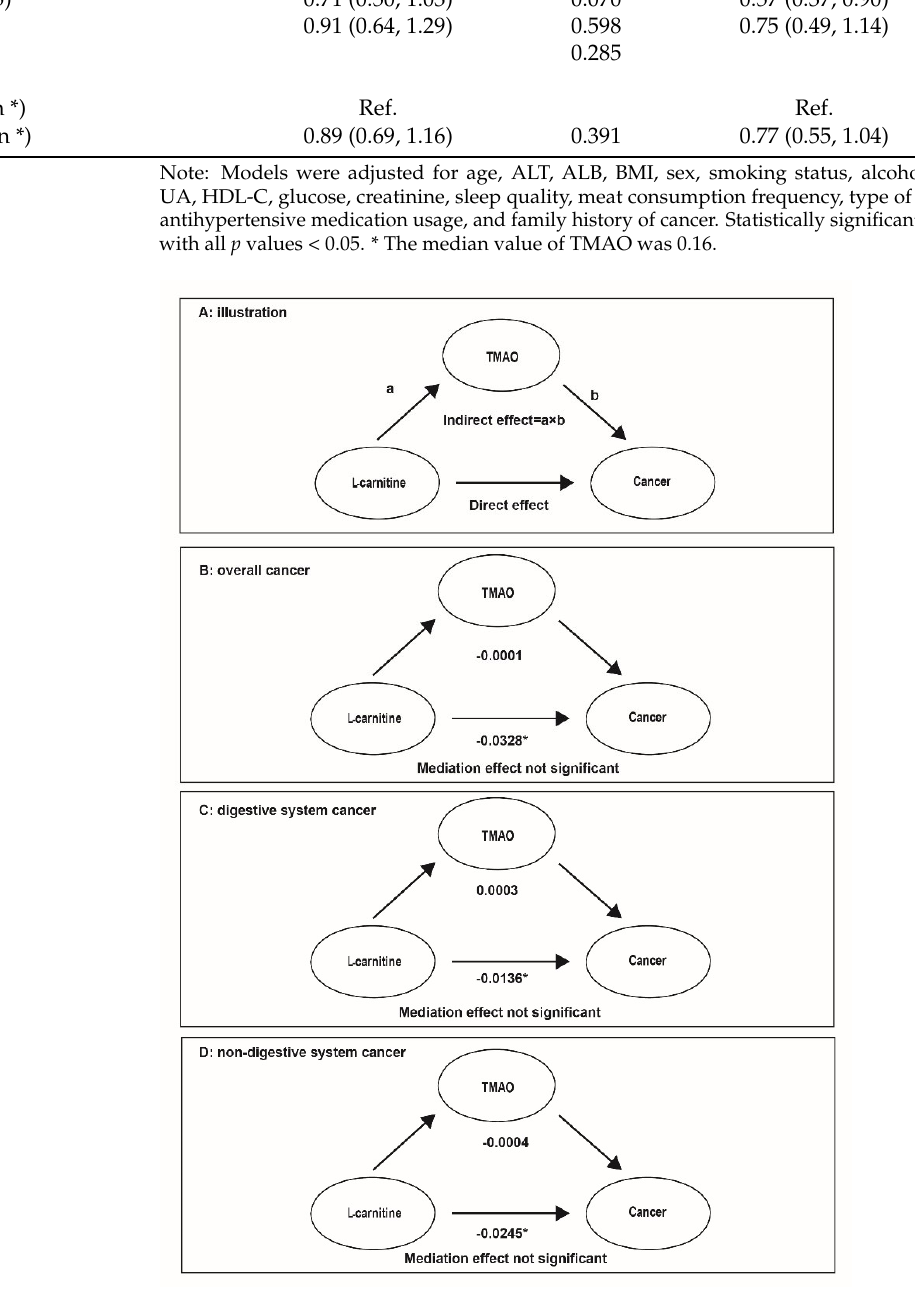
Figure 4. The mediation effect between LC, TMAO, and cancer risk. Note: Models were adjusted for ALT, ALB, BMI, smoking status, alcohol drinking, SBP, TC, TG, UA, HDL-C, glucose, creatinine, sleep quality, meat consumption frequency, type of meat consumed, oral antihypertensive medication usage, and family history of cancer, except for the stratified factors. * Values were statistically significant. 4. Discussion This population ‐ based, prospective, case ‐ control study, nested within the CHHRS, found that individuals with hypertension with greater serum LC levels had a lower risk of overall cancer. Significant associations were similarly observed for digestive system and non ‐ digestive system cancer. Similar results were also identified among participants with higher BMI, never drinkers, never smokers, and females. In addition, the reversed association of LC with cancer risk was not mediated by TMAO concentrations. In the current study, we firstly found a non ‐ linear and reversed association between serum LC and cancer risk. The risk of cancer is initially elevated and then significantly